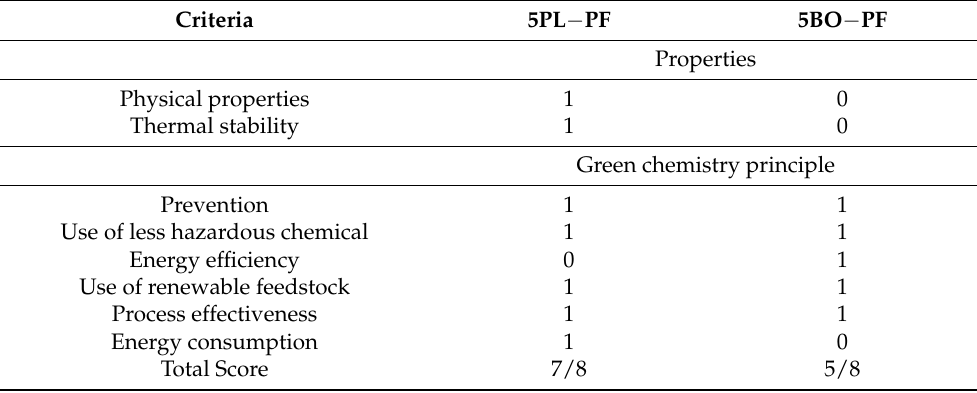
Table 4. Evaluation of the production of PL − PF and BO − PF resins based on the physical properties and green chemistry